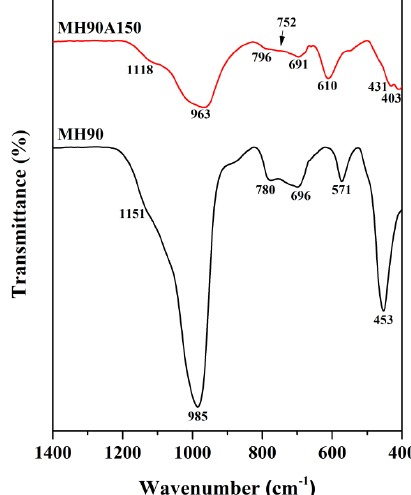
Table 2. Band assignment of FTIR spectra of MH90 ( FAU ) and MH90A150 ( GIS) samples. Figure 5. XRD patterns of zeolites from microwave-assisted hydrothermal method at 90 °C for 1 h (MH90), aged at room temperature for 23 h (MH 90A) and crystallized at 150 °C for 1 h (MH90A150).